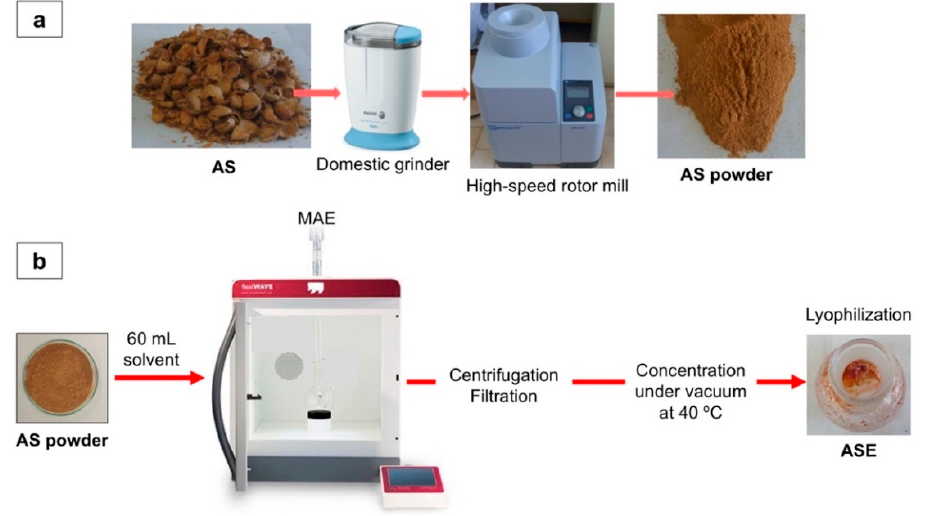
Figure 1. Scheme of ( a ) AS powder preparation and ( b ) MAE process to obtain ASE.